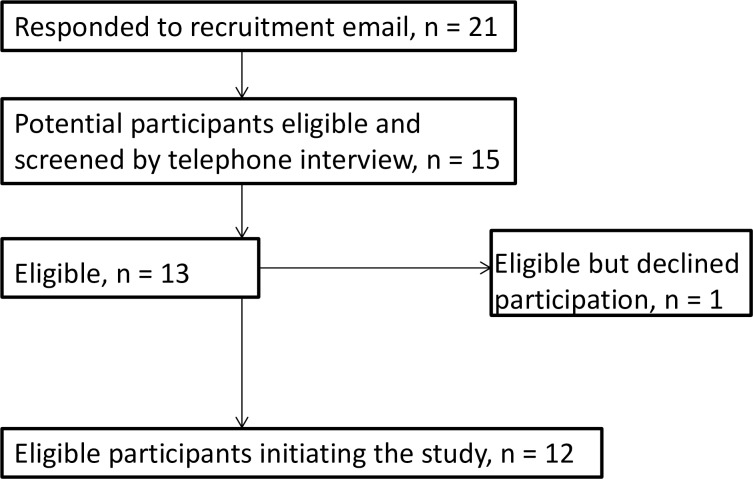
Flow chart describing participant recruitment.